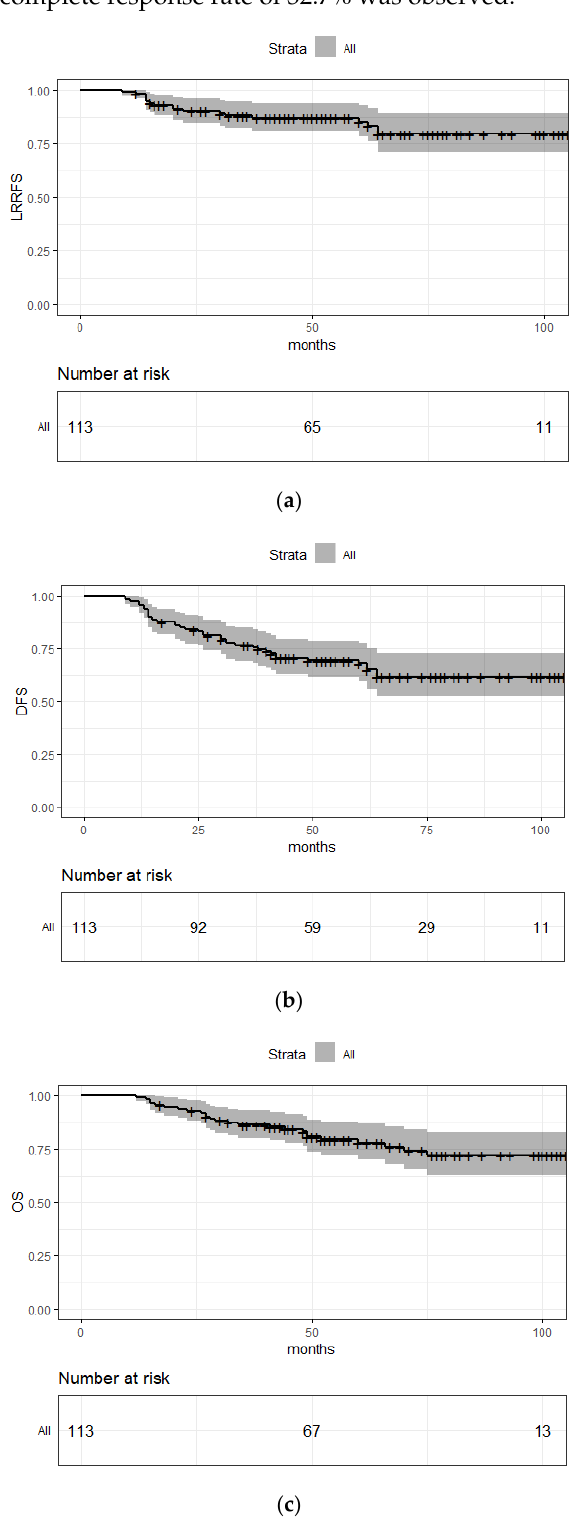
Figure 1. Survival outcomes: ( a ) LRRFS; ( b ) DFS; ( c ) OS.